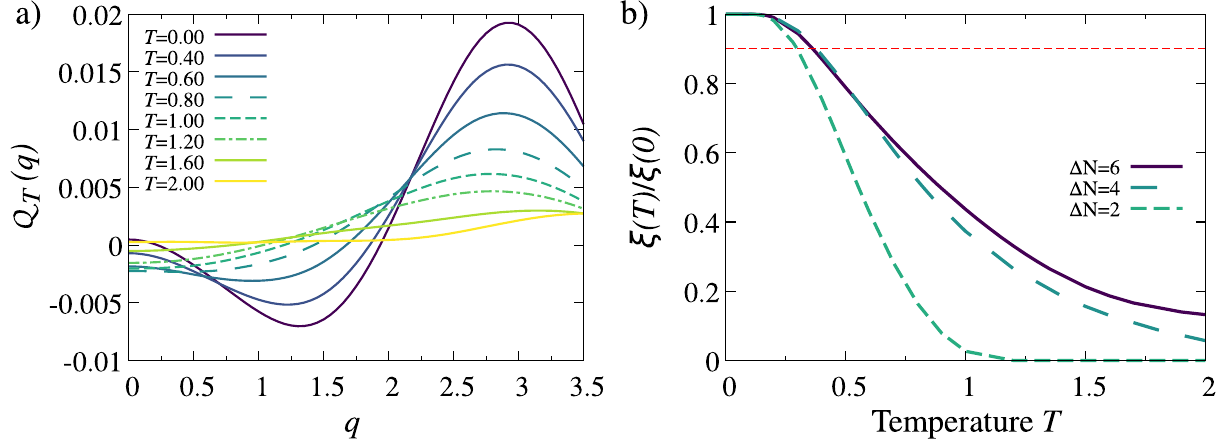
3 . ( a ) Distribution of 8 particles and interaction g Figure 5. Thermal properties of the system with N = − = 6 calculated the net momentum of correlated pairs Q T ( q ) for system with a very large particle imbalance (cid:31) N = for different temperatures T . Note that increasing temperature reduces the intensity of the maximum and 0 . ( b ) The measure ξ( T )/ξ( 0 ) as a function of temperature for shifts its position towards zero momentum q = 2, 4, 6 . All momenta and temperatures are expressed in natural units of the different particle imbalances (cid:31) N = problem, i.e., √ ℏ m ω and ℏ ω/ k B ,